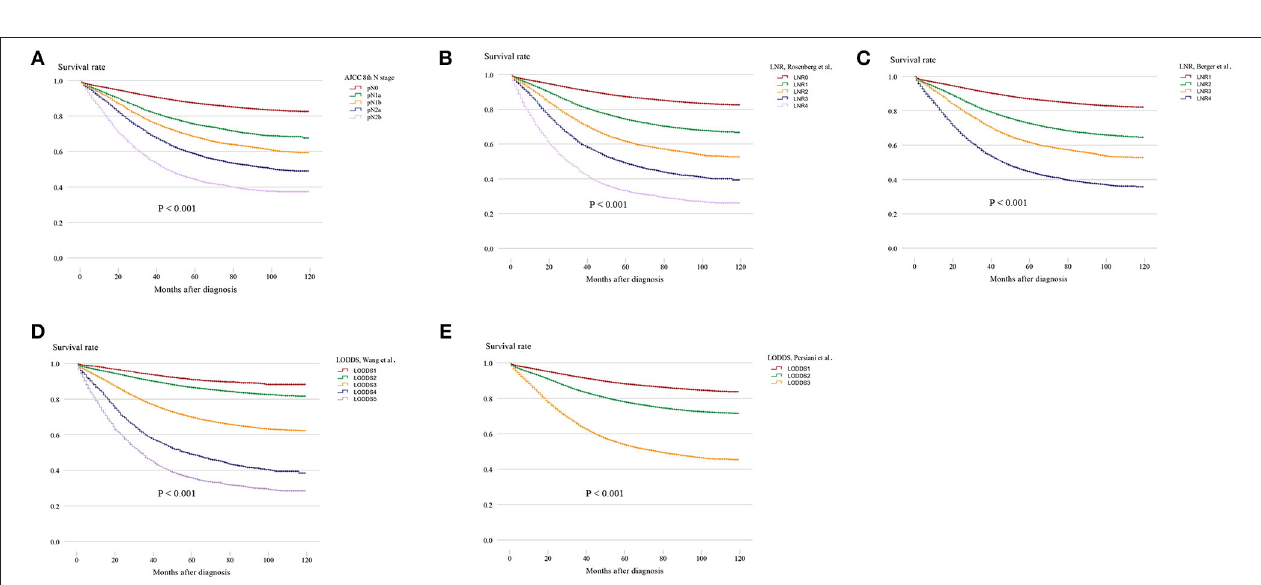
FIGURE 1 | Kaplan–Meier survival curves for five-year OS stratified by different prognostic factors with statistical significance based on the (A) Age, (B) Histologic grade, (C) Tumor size, (D) AJCC 8th T stage, (E) NDLN, (F) Gender, and (G) Tumor location. (AJCC, American Joint Committee on Cancer; NDLN, the number of dissected lymph nodes).